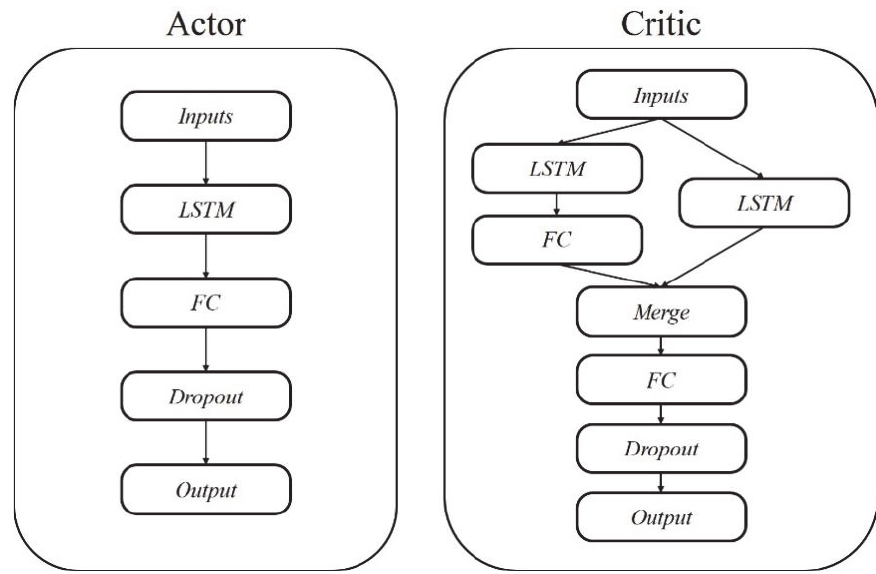
Figure 8. The architecture of the Actor and the Critic.